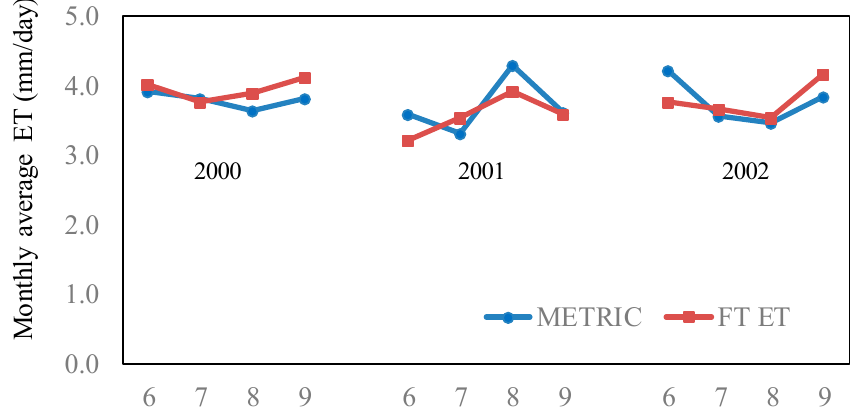
Figure 8. Monthly average ET derived from both METRIC and the flux tower over the dry season (June–September) for the RJA site.